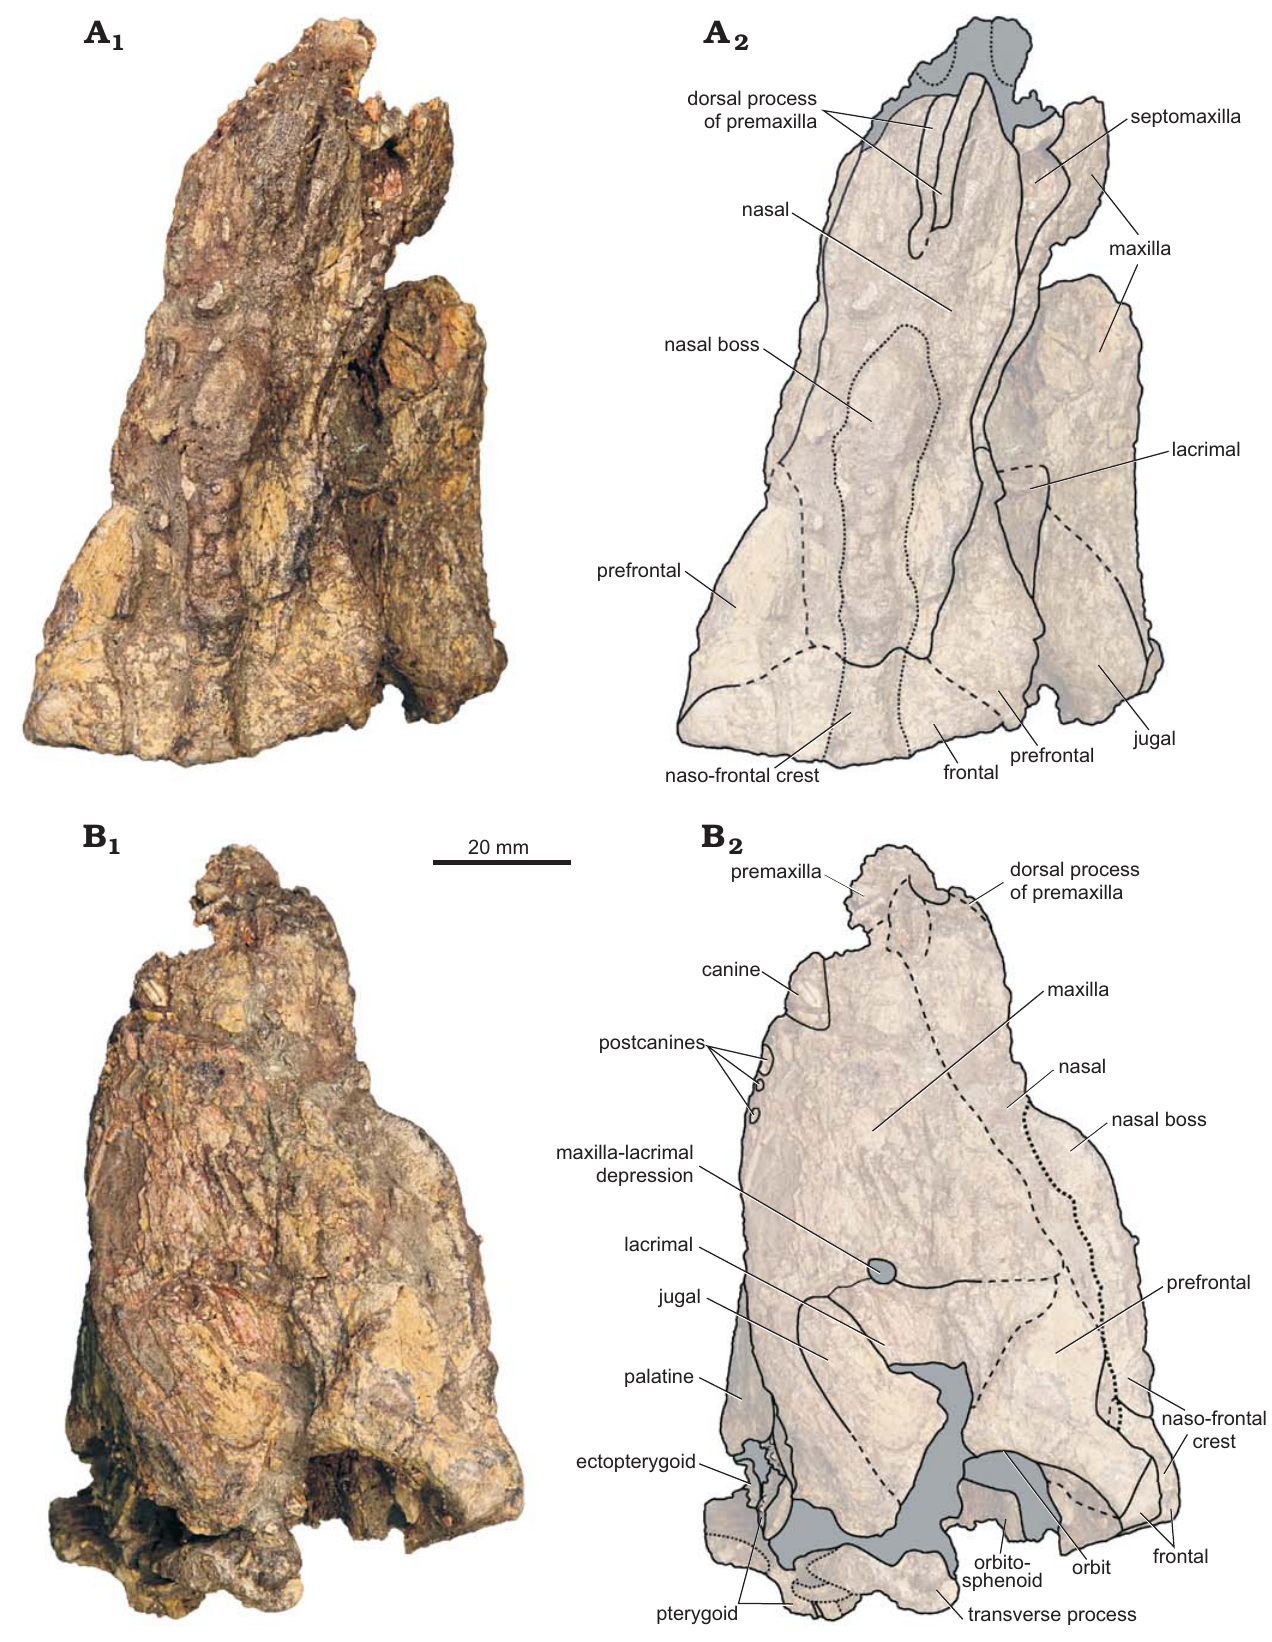
Fig. 3. Burnetiamorpha gen. et sp. indet. (BP/1/7098) from Springfontein, Beaufort West district, South Africa; upper Poortjie Member, Pristerognathus AZ, latest Capitanian; in dorsal ( A ) and left lateral ( B ) views. Photographs (A 1 , B 1 ) and explanatory drawings (A 2 , B 2